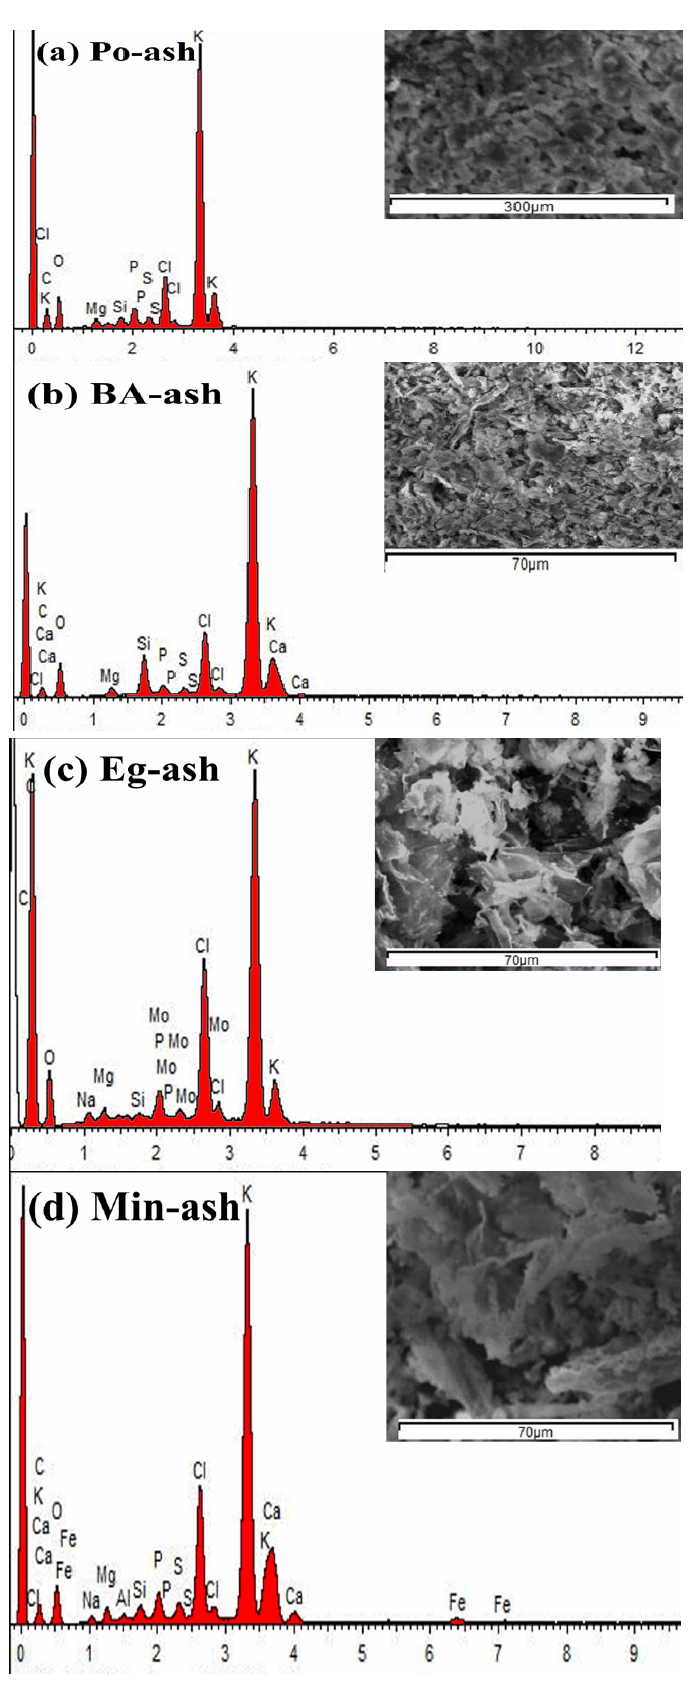
Figure 3. EDX–SEM analyses for ( a ) Po-ash; ( b ) BA-ash; ( c ) Eg-ash; ( d ) Min-ash